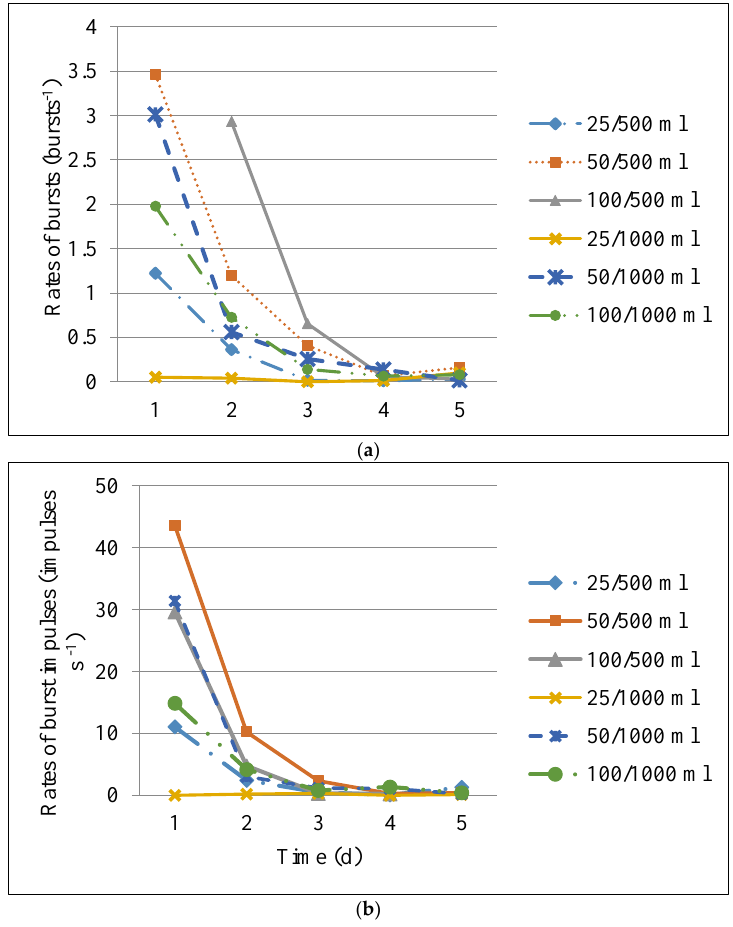
Figure 3. Burst rates ( a ) and rates of impulses in bursts ( b ) for 25, 50, and 100 Callosobruchus maculatus adults enclosed in hermetically sealed 500 mL jars and 1000 mL jars during the first 5 d of hermetic storage.